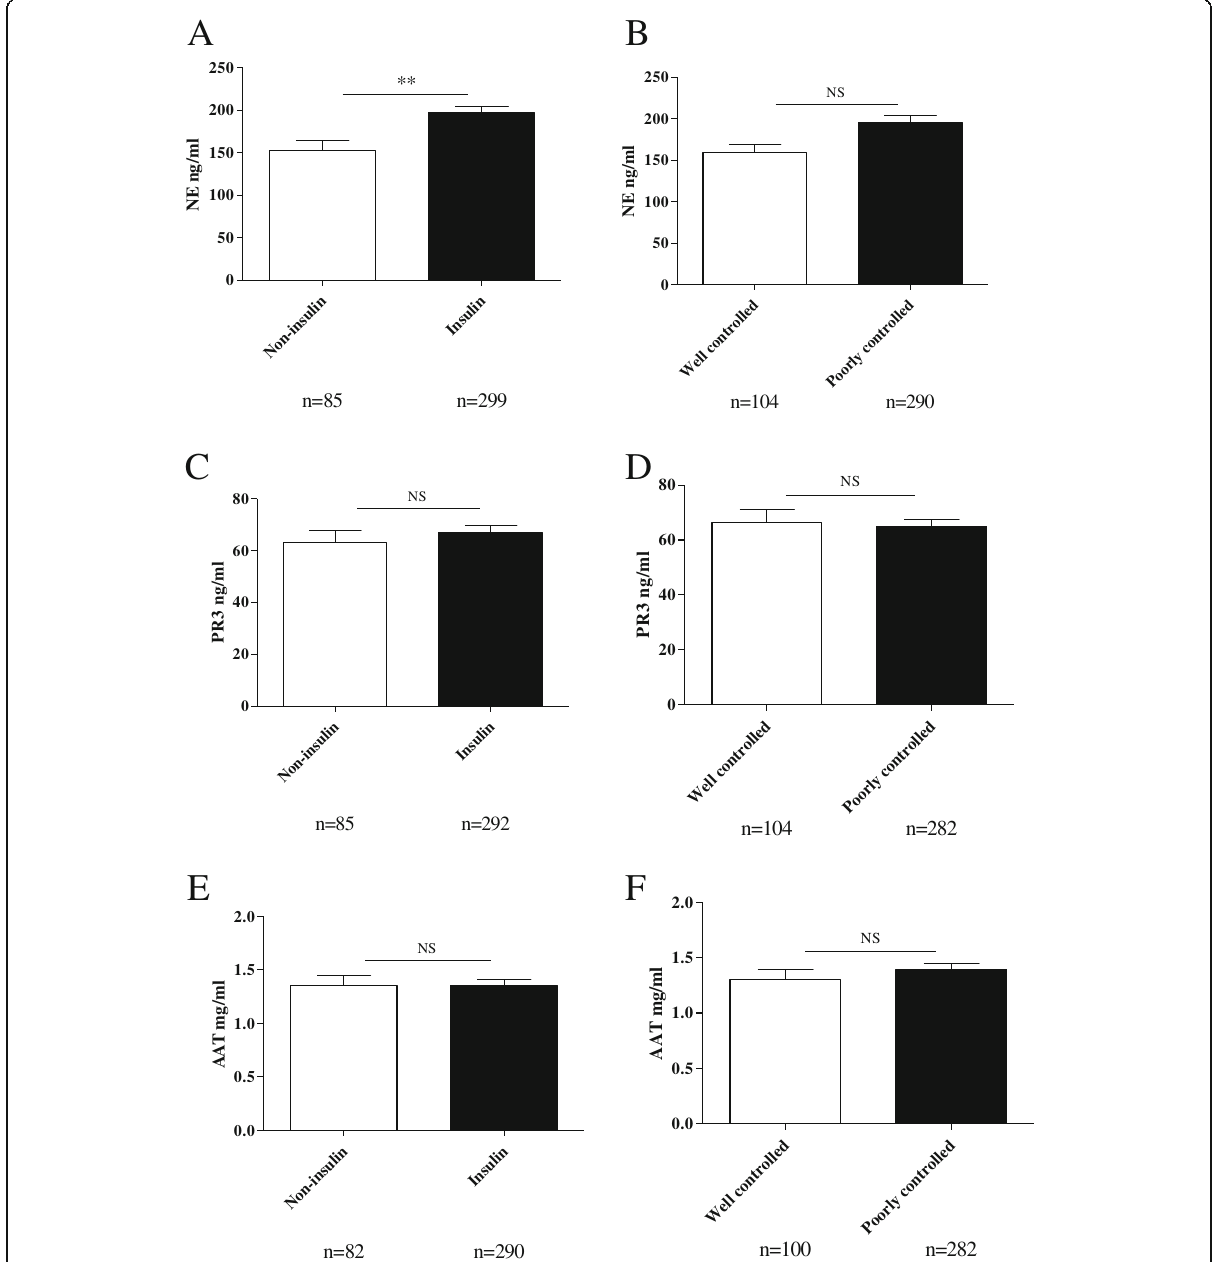
Fig. 3 PR3, NE and AAT plasma concentrations in patients with type 2 diabetes. a NE plasma concentrations in patients that didn't use insulin drugs versus patients that also used insulin. b NE plasma concentrations between patients with well controlled glycaemia versus patients with a poor control of glycaemia. c PR3 plasma concentrations in patients that didn't use insulin versus patients that also used insulin. d PR3 plasma concentrations between patients with well controlled glycaemia versus patients with a poor control of glycaemia. e AAT plasma concentrations in patients that didn't use insulin versus patients that also used insulin. f AAT plasma concentrations between patients with well controlled glycaemia versus patients with a poor control of glycaemia. Data is represented as mean ± SEM. ** p < 0.01, NS= p >